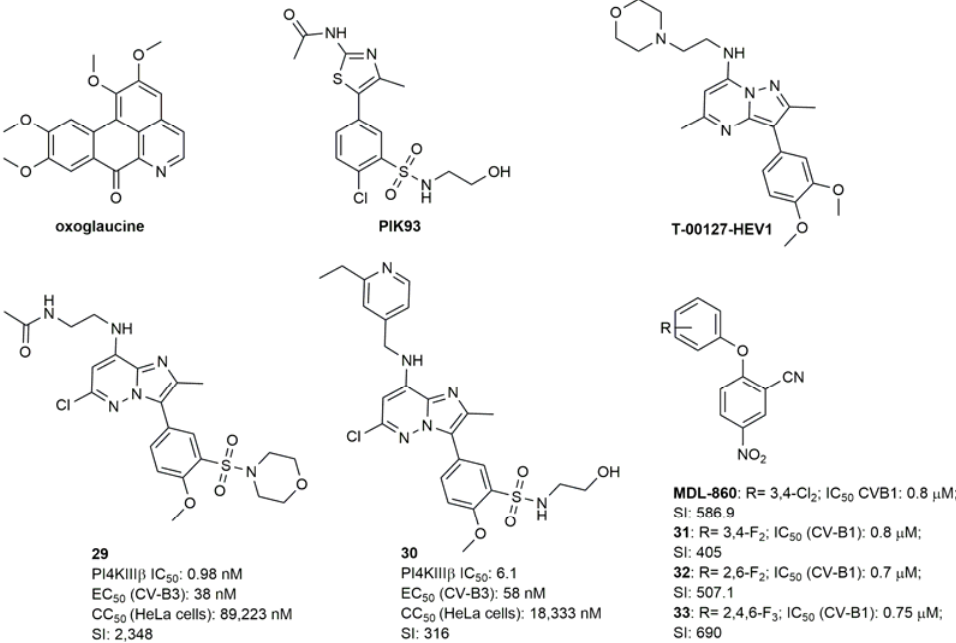
Figure 17. Chemical structures of the PI4KIII β inhibitors and biological activities of compounds 29 – 33 .